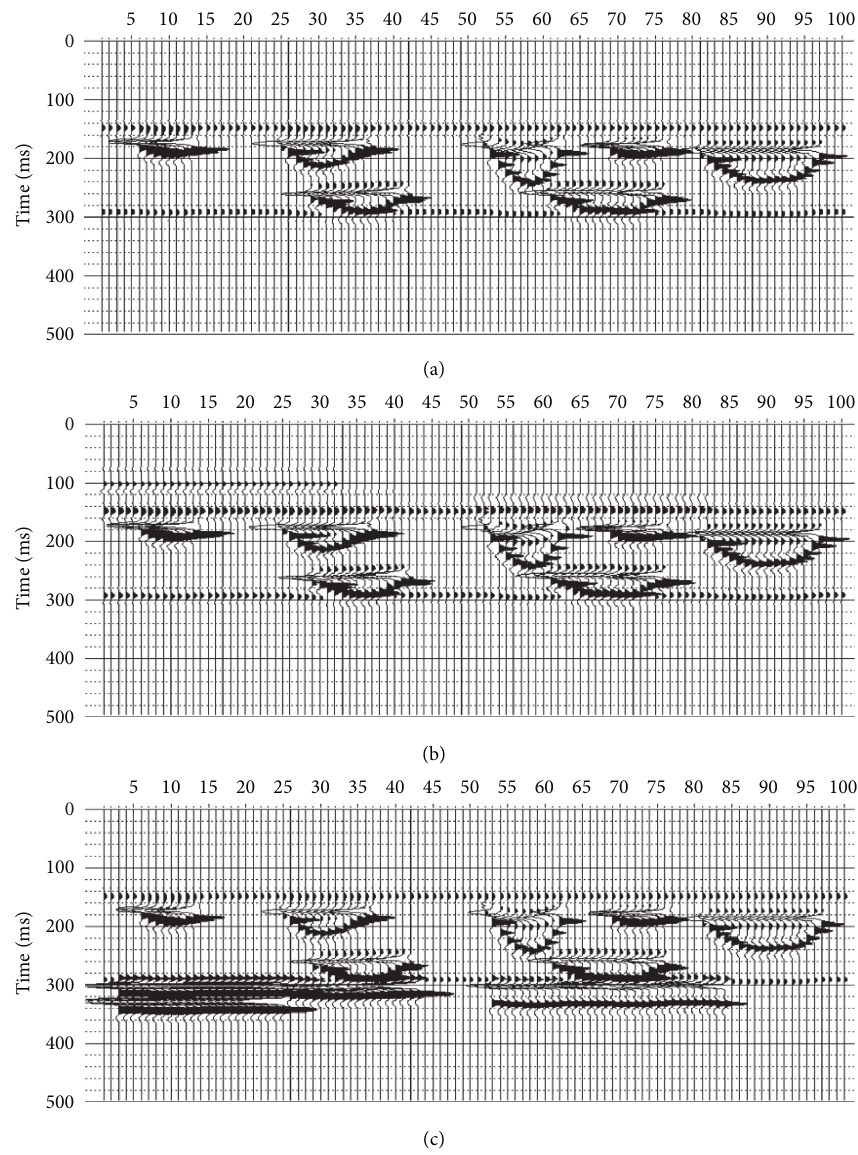
Figure 5: Synthetic seismic records of different 2D channel geological models at 30Hz. (a) Noninterference. (b) Upper interference. (c) Lower